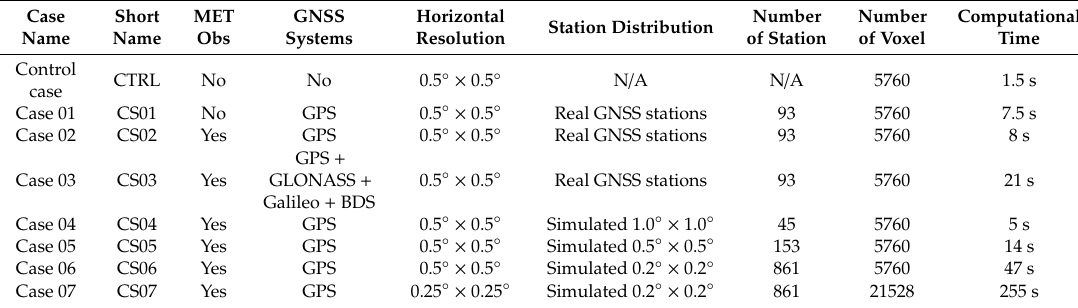
Table 1. Setup of tomographic experiments.